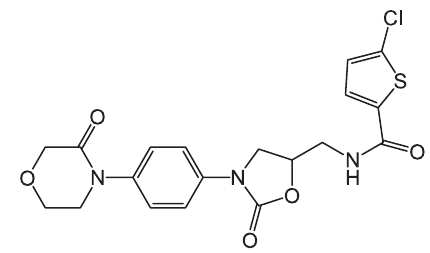
FIGURE 1 - Chemical structure of rivaroxaban.